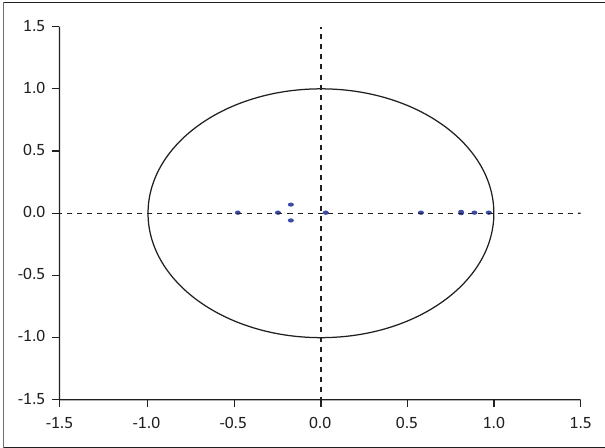
FIGURE 2: Stability test results: Inverse roots of autoregressive characteristic